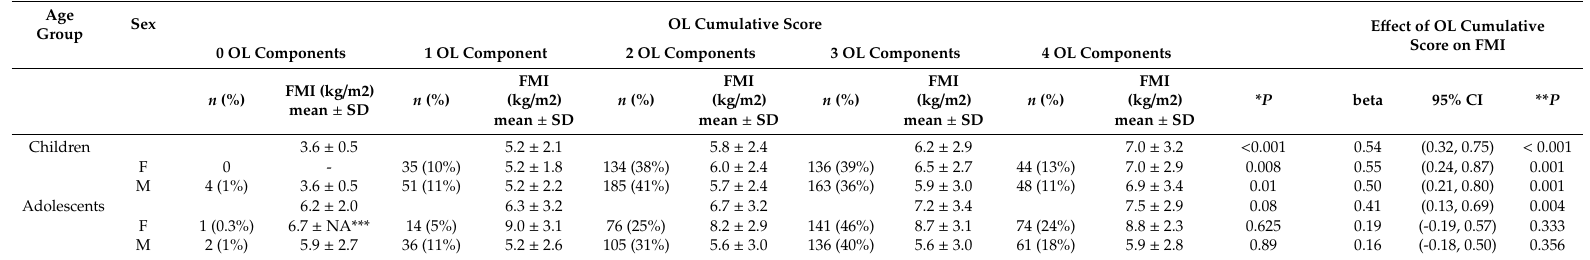
Table 5. Relationships between OL cumulative score with FMI (kg / m2) in Mexican children and adolescents.